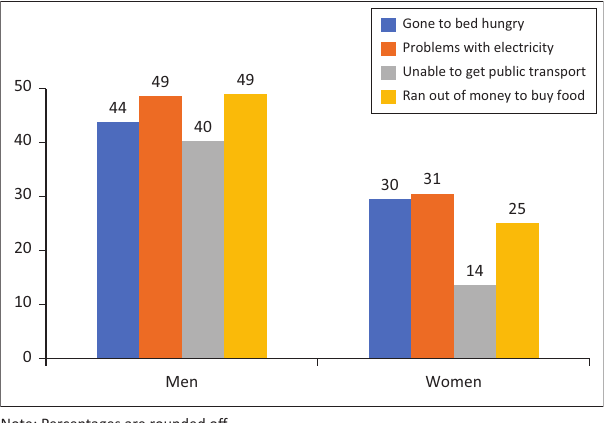
FIGURE 2: The coronavirus disease 2019 economic impact of lockdown ( N =